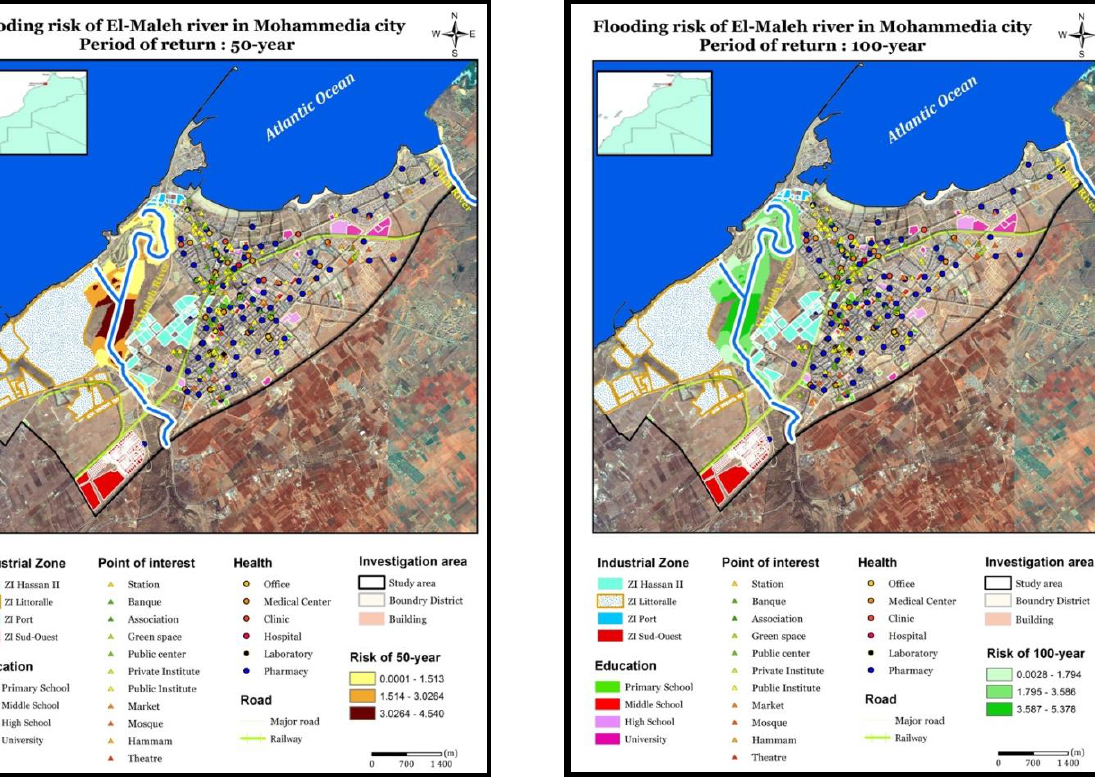
Figure 10. Flooding risk of a